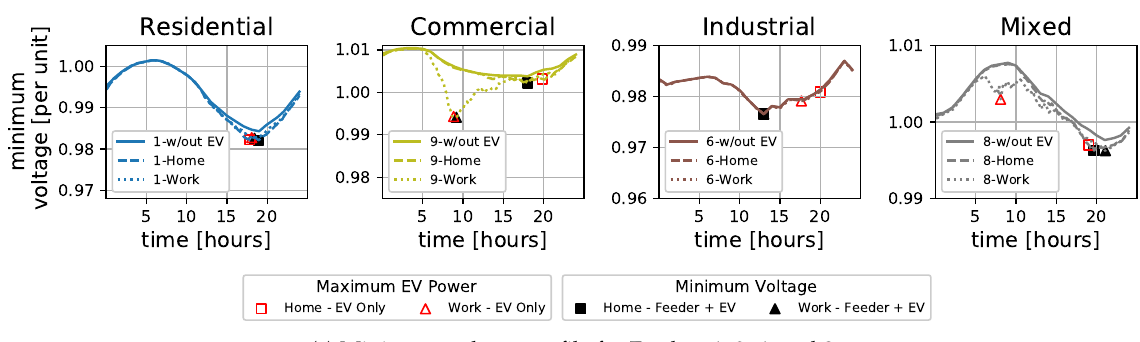
Figure 10. Sample feeders from each cluster type described the potential cause for the worst case line loading and voltage. ( a ) Describes the four feeders (1, 9, 6, and 8) power demand for a 24 h period under the three different EV loading conditions. ( b ) Highlights the line loading percentages throughout the day for each scenario and markers that describe the EV and overall power peak times. And, ( c ) describes the minimum feeder voltage profiles define the time and extent of the worst case voltage; the markers identify how the lowest voltage corresponds to the EV and overall feeder